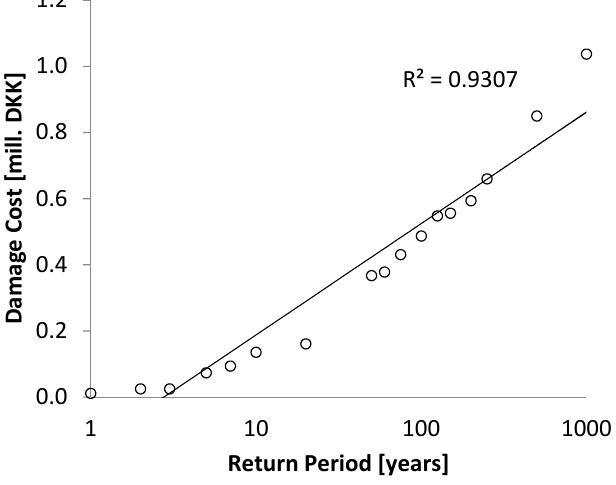
Figure 10. Log-linear relation for the study area located in the city of Aarhus. Note that this area has lower damage costs than the area located in